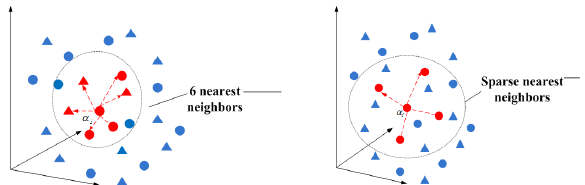
Figure 3: Illustration of 6-nearest neighbors and sparse nearest neighbors policy. The circles and triangles represent the data points from two different local subspaces respectively. The red points denote the estimated neighbors for the observed data α i from the same local subspace under the determinate searching